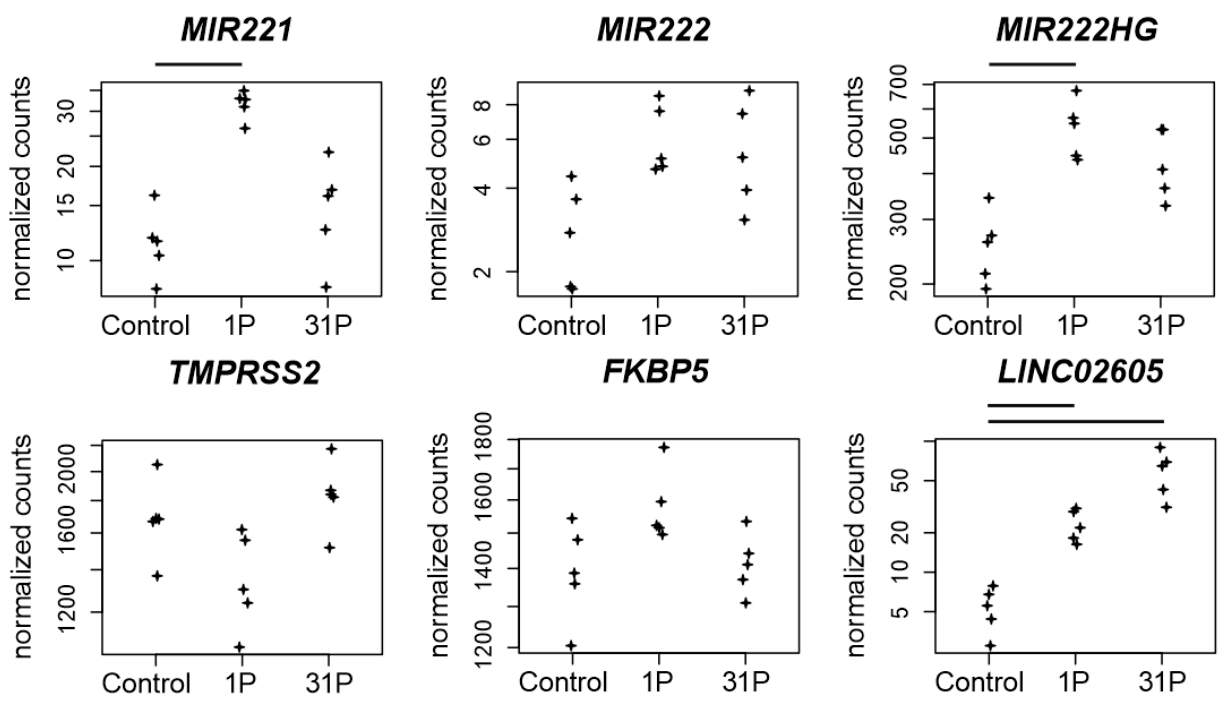
Figure 6. Normalized PF RNAseq counts of four non-coding RNAs and two protein coding RNAs. Expressions of the micro RNAs miR-221 and miR-222 , of the lncRNA MIR222HG , of the serine protease encoding TMPRSS2 gene, of the Peptidyl-Prolyl Cis-Trans Isomerase encoding gene FKBP5 and of the lncRNA LINC02605 are given. Bars on top of the graph indicate two-fold significant (P adj < 0.05) differential expression between the